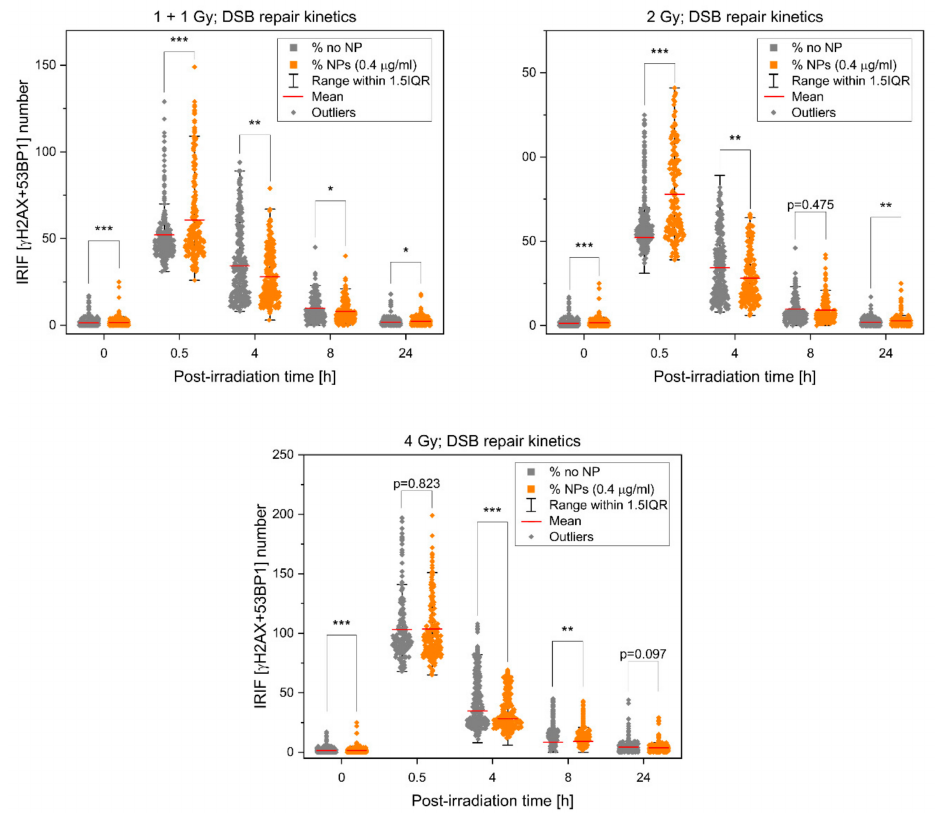
Figure 4. DSB repair kinetics compared for SkBr3 cells exposed to 1 + 1, 2 or 4 Gy of γ -rays in the presence ( orange ) or absence ( gray ) of 10 nm GNPs (0.4 µ g/mL). The average numbers